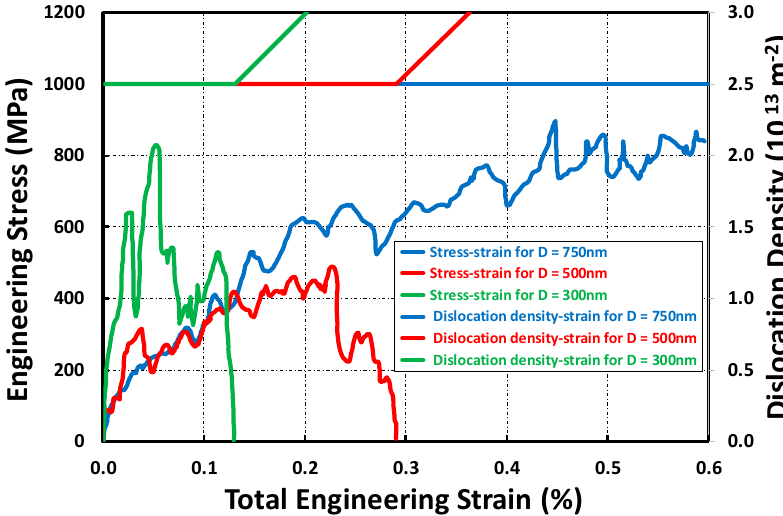
Total Engineering Strain (%) Figure 8. Numerically predicted evolution of engineering stress and dislocation density versus total strain in a series of single crystal Ni micropillars of different diameters (after Zhou et al. [55]).